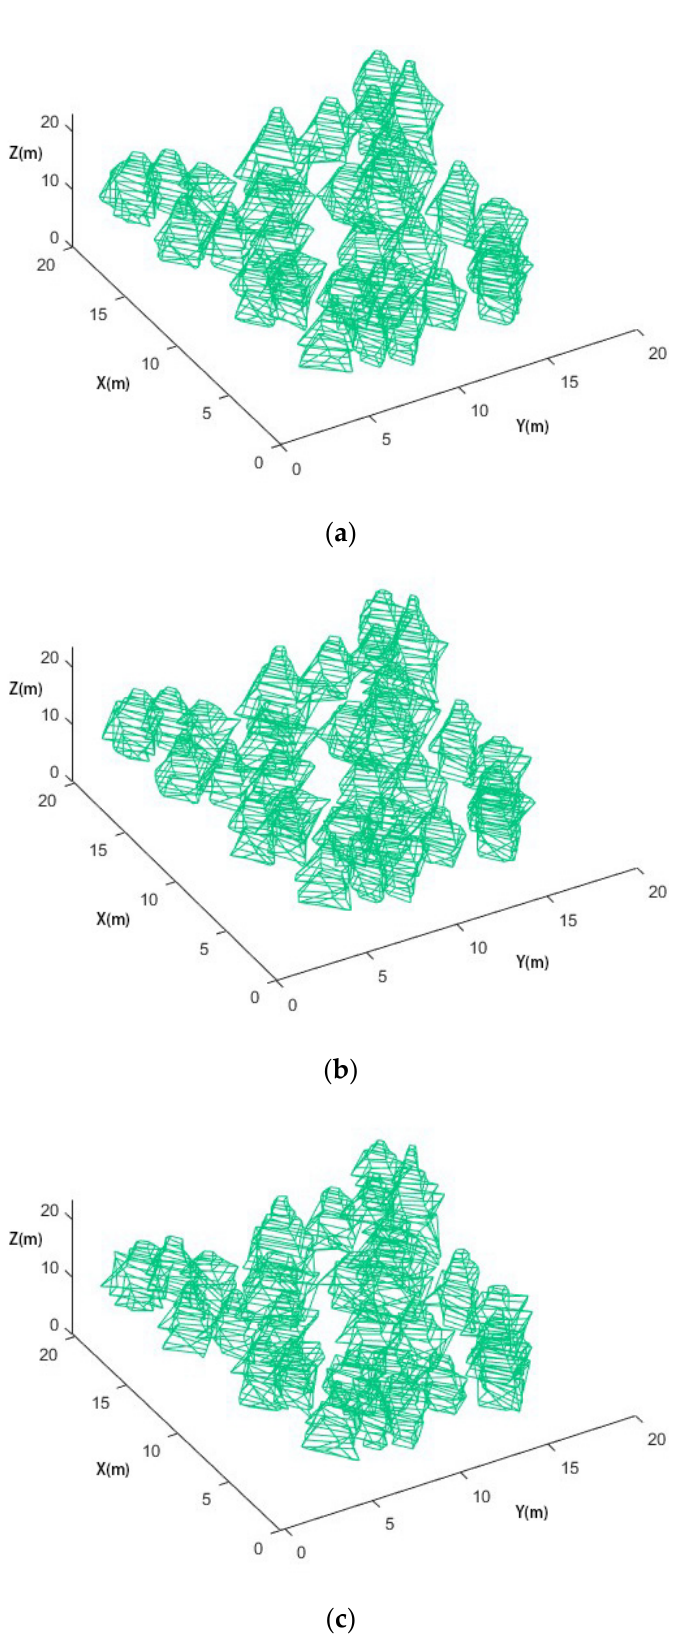
Figure 7. Schematic diagrams of canopy morphological data in 3D space: ( a ) Current_CMDD; ( b ) Current_CMDD_CCLM; and ( c ) Current_CMDD_SS.